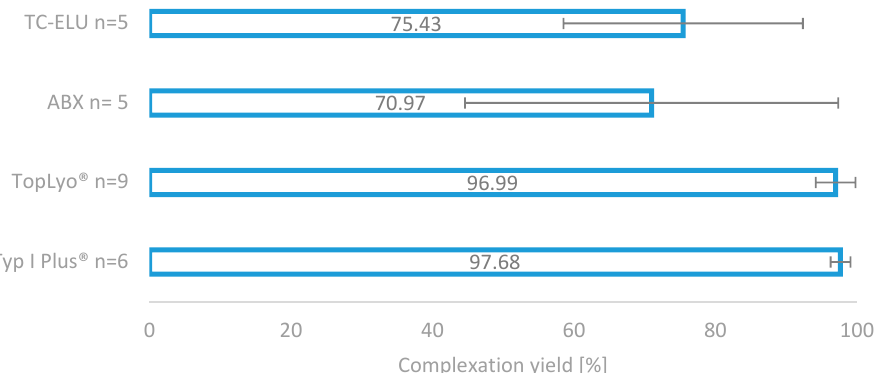
Figure 4. Comparison of the four di ff erent reactor vials for radiolabelling. Two normal glass reactors, as well as two silicone-coated glass reactors.